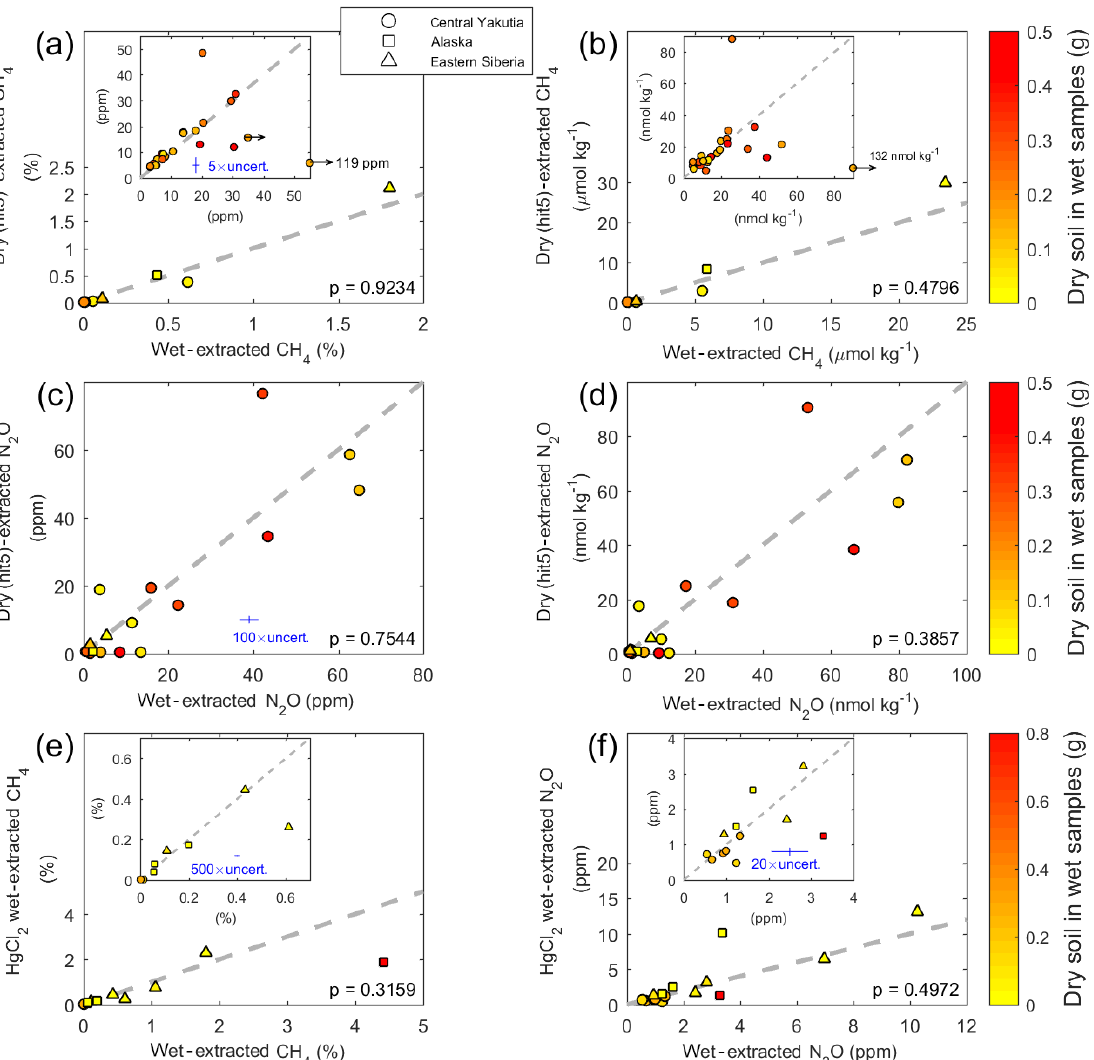
Figure 1. Comparison of CH 4 and N 2 O mixing ratios and contents obtained by different extraction methods. Shown are scatter plots between wet and dry (hit5) extraction results of CH 4 ( a and b ) and N 2 O ( c and d ), and between control and biocide-treated wet extraction results for CH 4 (e) and N 2 O (f) . The “hit5” denotes the dry extraction with five hits (see Sect. 3.3). Left panels ( a , c , and e ) and panel (f) present the mixing ratios of gas in bubbles, while panels (b) and (d) in the right column present moles of gas in a unit mass of ice (gas content). The sampling locations are indicated by different symbols. The colour of each data point indicates the dry soil weight in the subsamples used in control wet extraction. The 1 σ uncertainties of the mixing ratios ( a , c , e , and f ) are magnified by 5 × , 20 × , 100 × , and 500 × as denoted as blue error bars (see Appendix). The error bars are not visible where the error bars are smaller than markers. The grey dashed lines are 1 : 1 reference lines. Note that the units of the axes of the insets in (e) and (f) are identical to the original plots. The p value of the two-sided Students t test of each comparison is denoted at the bottom right corner of each